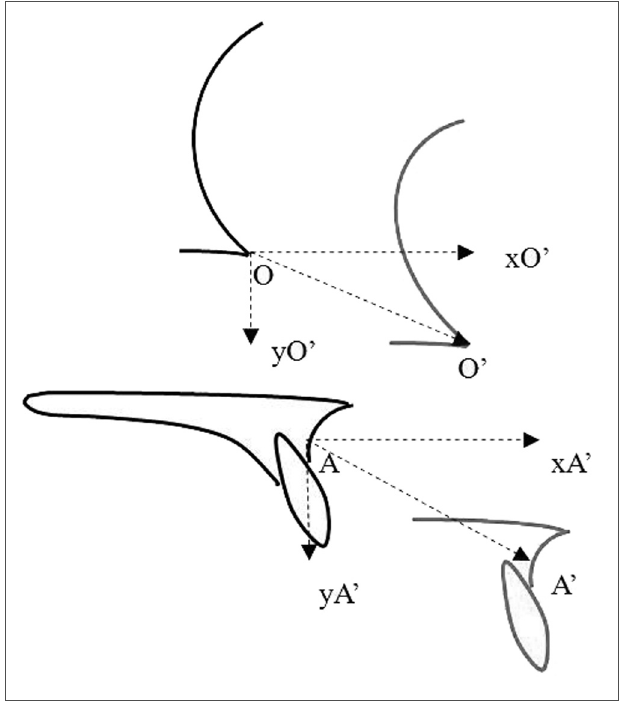
Figure 3. Representation of mean distances between preoperative tracings (in black) and early postoperative tracings (in red). A: point A in the preoperative tracing; A’: point A no early postoperative tracing; xA’: projection of point A’ on the horizontal axis drawn from point A; yA’: projection of point A’ on the vertical axis drawn from point A; O: orbit point on the early postoperative tracing; O’: orbit point on the early postoperative tracing; xO’: projection of point O’ on the horizontal axis drawn from point O; yO’: projection of point O’ on the vertical axis drawn from point O. A-A’: distance between points A and A’ = resulting displacement measured from point A, on the movement vector; A-xA’: distance between point A and the projection of point A’ on the horizontal axis = horizontal advancement measured from point A. A-yA’: distance between point A and projection of point A’ on the vertical axis = vertical displacement measured from point A; O-O’: distance between points O e O’ = resulting displacement measured from point O, on the movement vector; O-xO’: distance between point O and projection of point O’ on the horizontal axis = vertical displacement measured from point O; O-yO’: distance between point O and the projection of point O’ on the vertical axis = vertical displacement measured from point O.